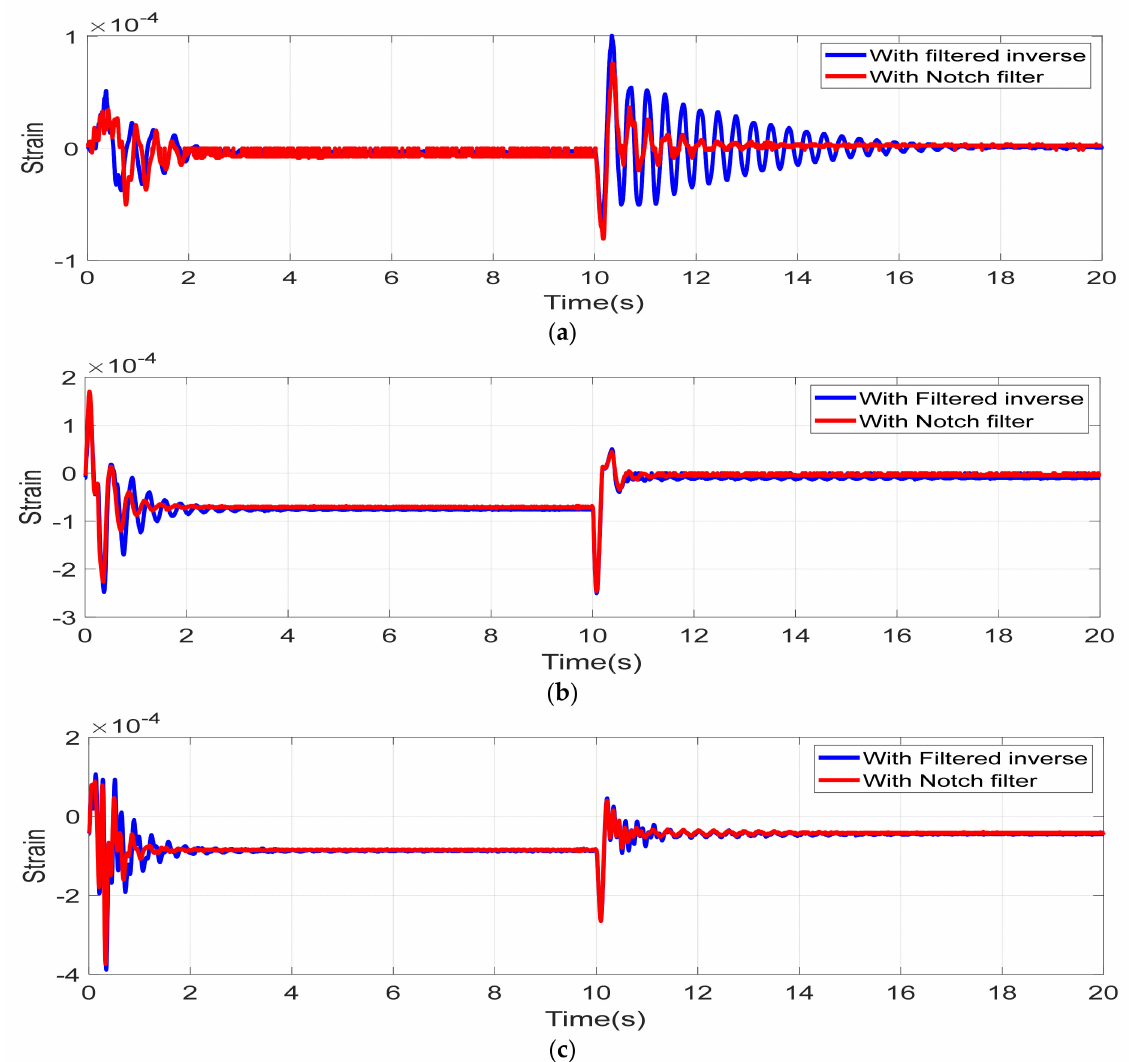
Figure 11. Link strain. ( a ) Torsion, ( b ) Link 1 in plane, ( c ) Link 2 in